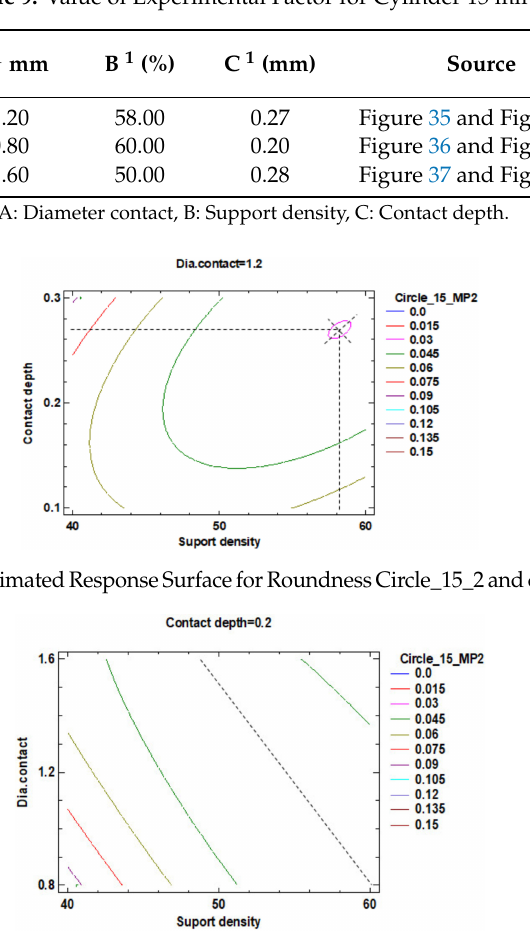
Figure 36. Contours of Estimated Response Surface for Roundness Circle_15_2 and centre contact depth.